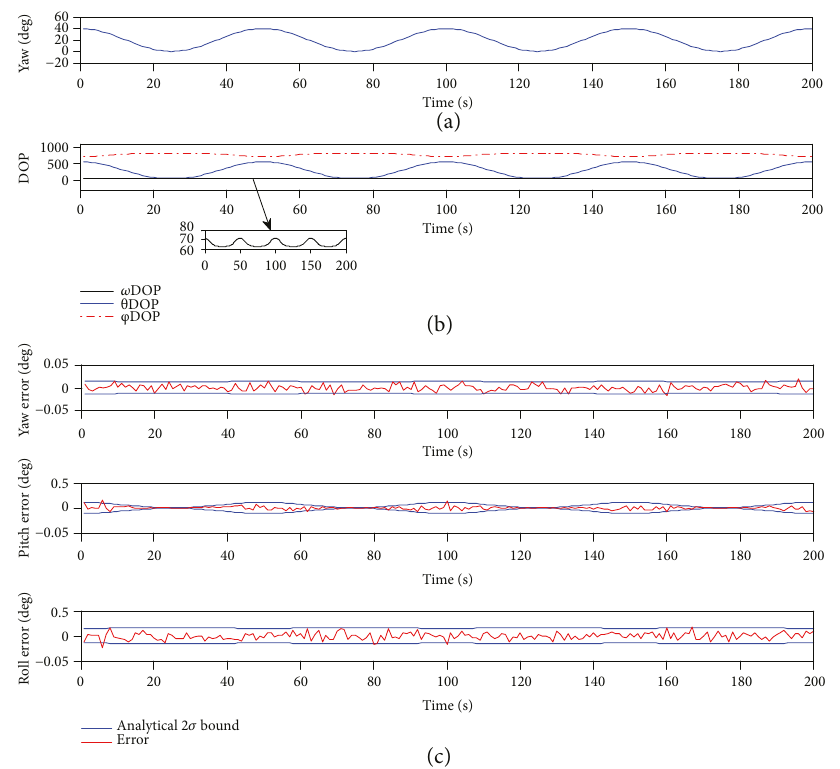
Figure 10: History of scenario 3: (a) history of yaw angle of satellite B; (b) history of the EUDOPs; (c) comparisons of elevation angle estimation errors against analytically calculated